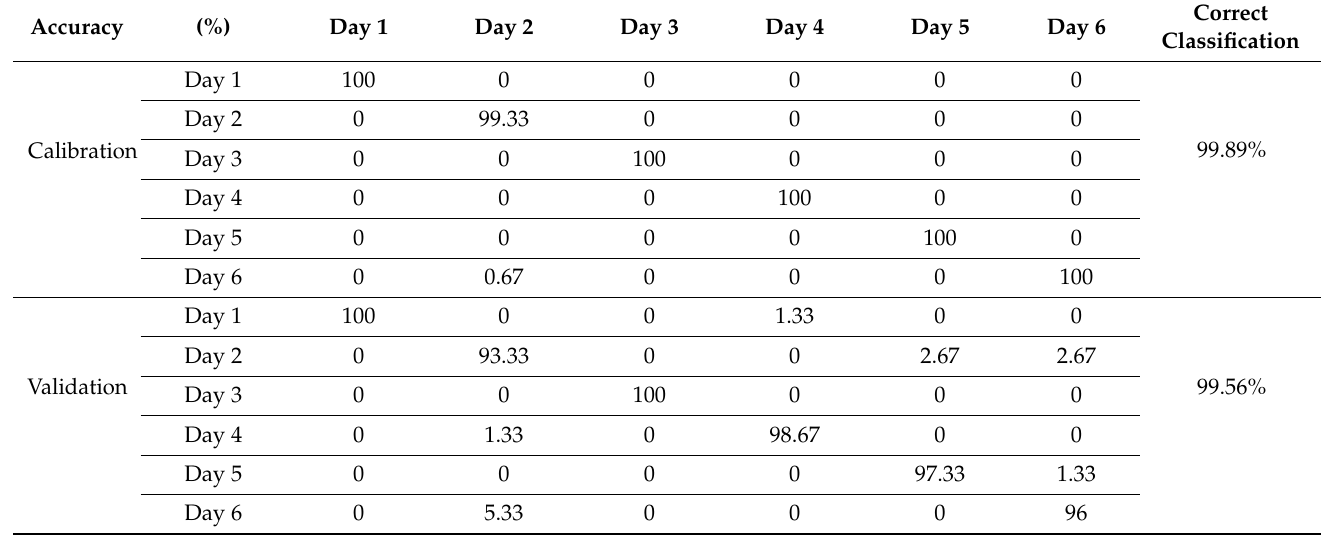
Table 2. PCA-LDA classification results on the data of outer leaves when “storage time” was the class variable (deTr-treated spectra, N = 450, NrPCs =